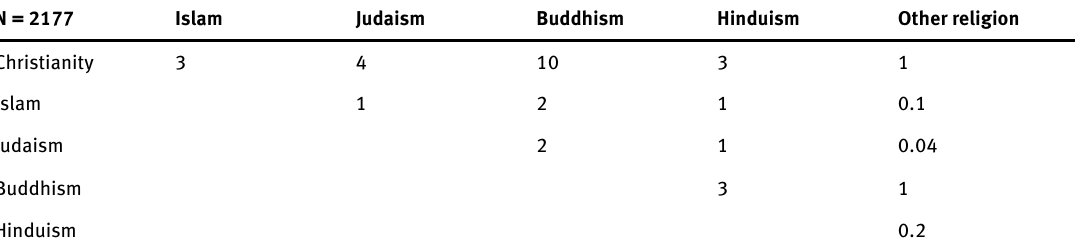
Table 1. Combination of elements from religious traditions in the emic approach in % of the population.